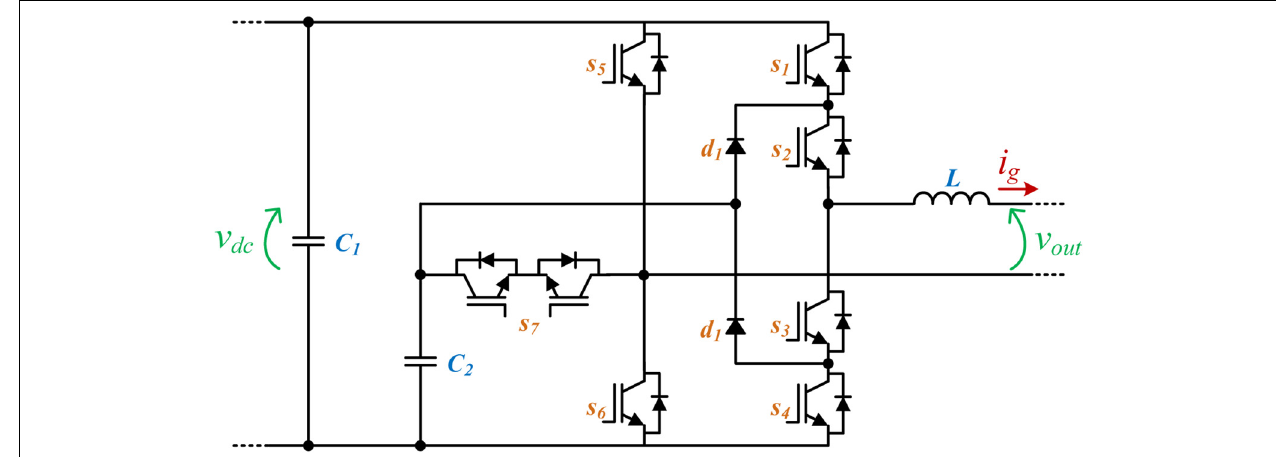
FIGURE 7 | Topology proposed in Gautam et al.